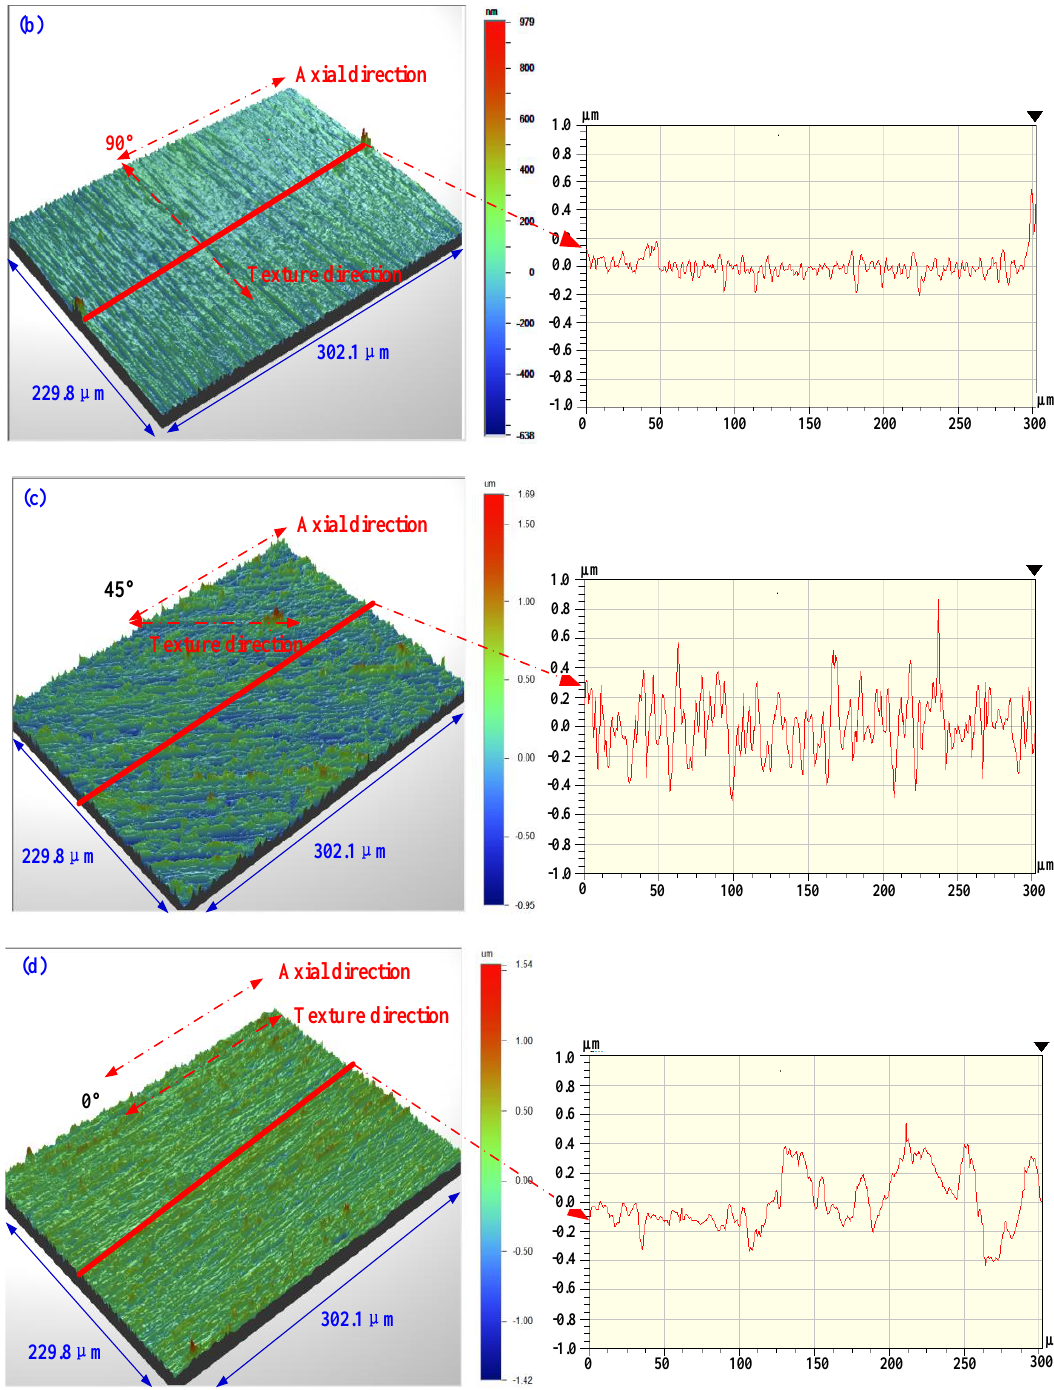
Figure 4. Surface topographies and surface profiles of GH4169: ( a ) FT process; ( b ) TCP process; ( c ) TCPO process and ( d ) TCPA process.